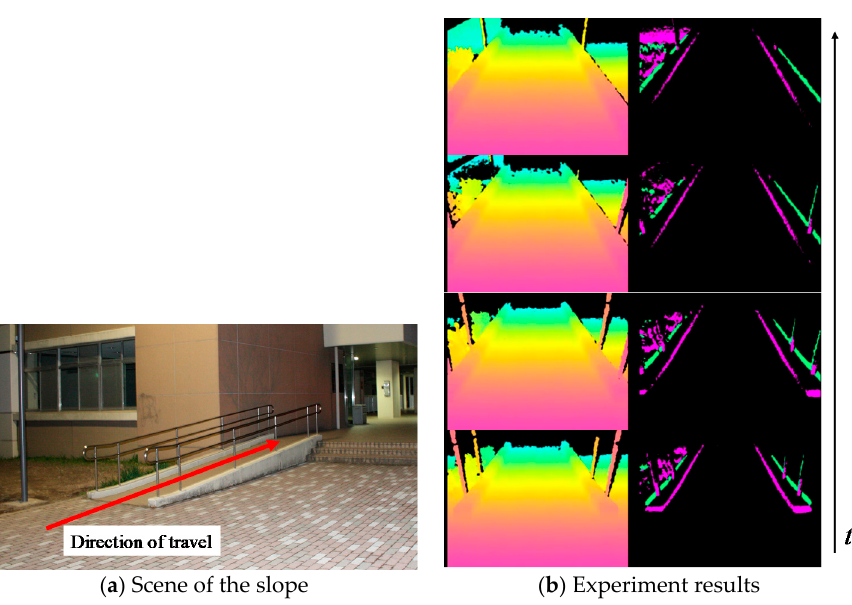
Figure 18. Results of the hazardous object detection in driving experiments on a slope.